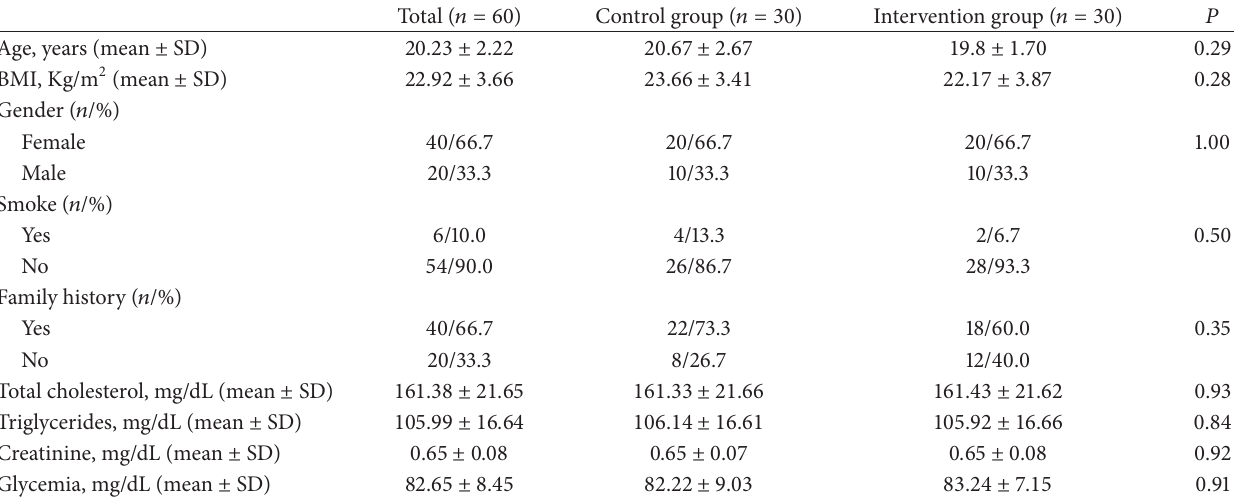
Table 1: Baseline study cohort characteristics.